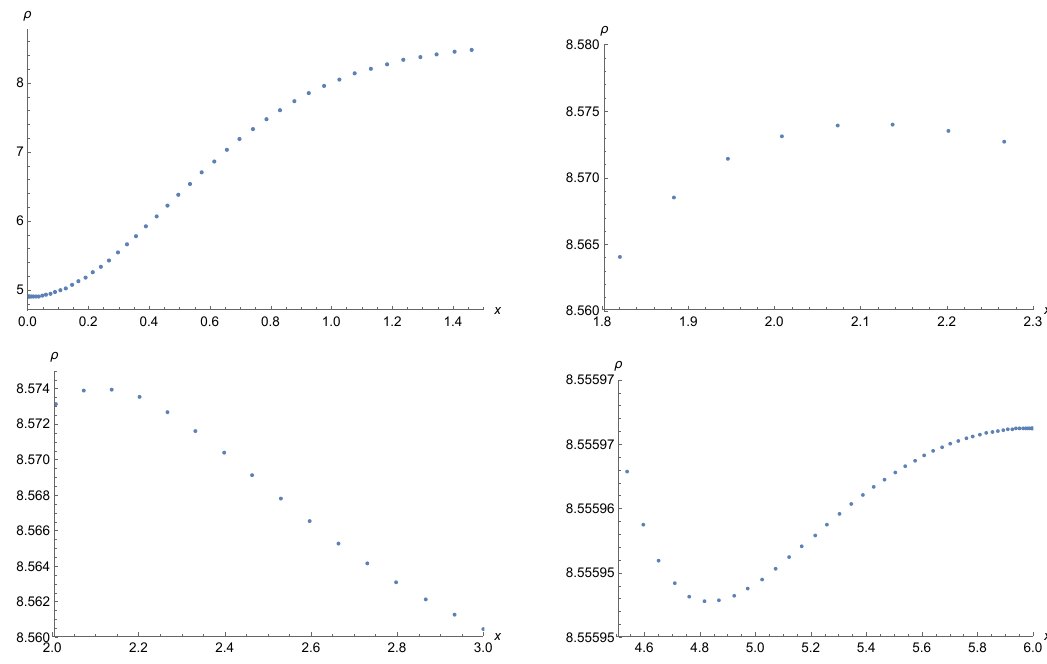
Figure 8 . The magni(cid:12)ed particle number density, at (cid:22) = 5 : 5, as a function of x from 0 to 6 (half plot of the box) under the standard quantization. It is clearly shown that they have (cid:13)uctuations.